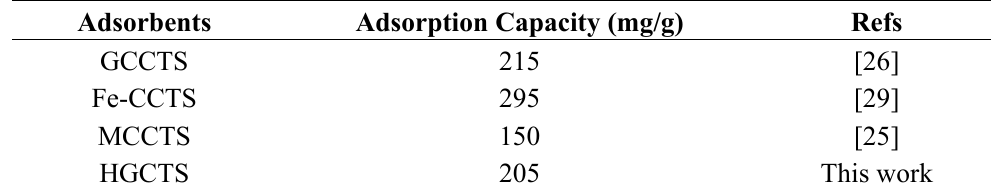
Table 7. Comparison of adsorption capacity for Cr(VI) on HGCTS with other adsorbents.